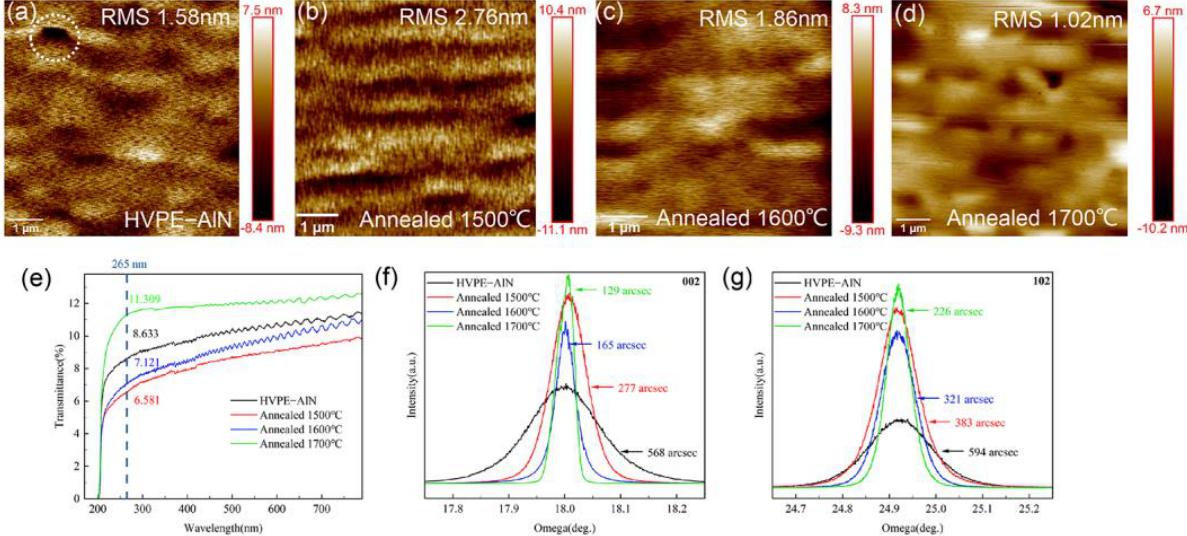
Figure 1. ( a ) HVPE − AlN samples; ( b ) AlN samples annealed at 1500 °C; ( c ) AlN samples annealed at 1600 °C; ( d ) AlN samples annealed at 1700 °C; ( e ) UV – vis plots of four groups of samples; ( f ) (002)- plane XRC plots of four groups of samples; ( g ) (102)-plane XRC plots of four groups of samples. Defects significantly impact not only the electrical characteristics of AlN-based op- toelectronic devices but also the AlN optical properties. Figure 1e shows the UV light transmittance spectra of the AlN epitaxial layers deducted from the air background before 8.633, 6.581, 7.121, and 11.309. The clear Fabry-P é rot interference fringes in the spectrum indicate a distinct interface between the AlN film and the sapphire. The transmittance